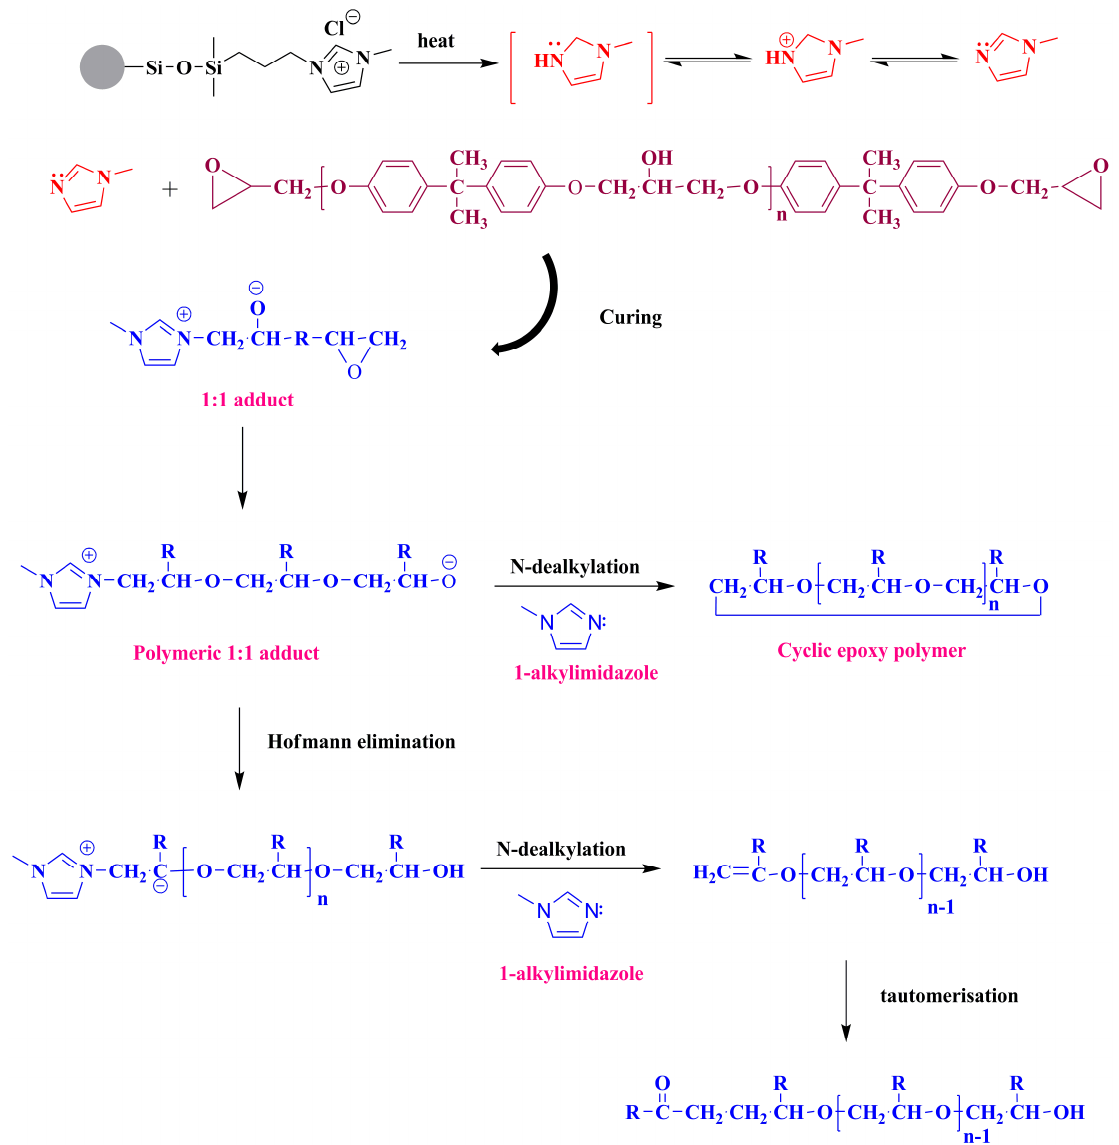
Figure 4. Schematic of cross-linking reactions between epoxy resin and IL-silica.